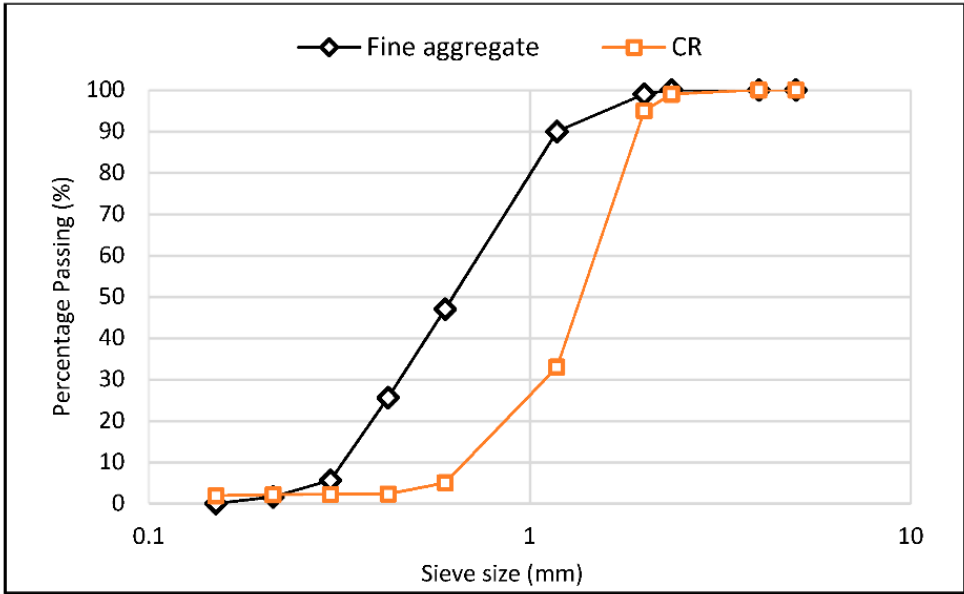
Figure 1. Grading curve for fine aggregate and CR used.